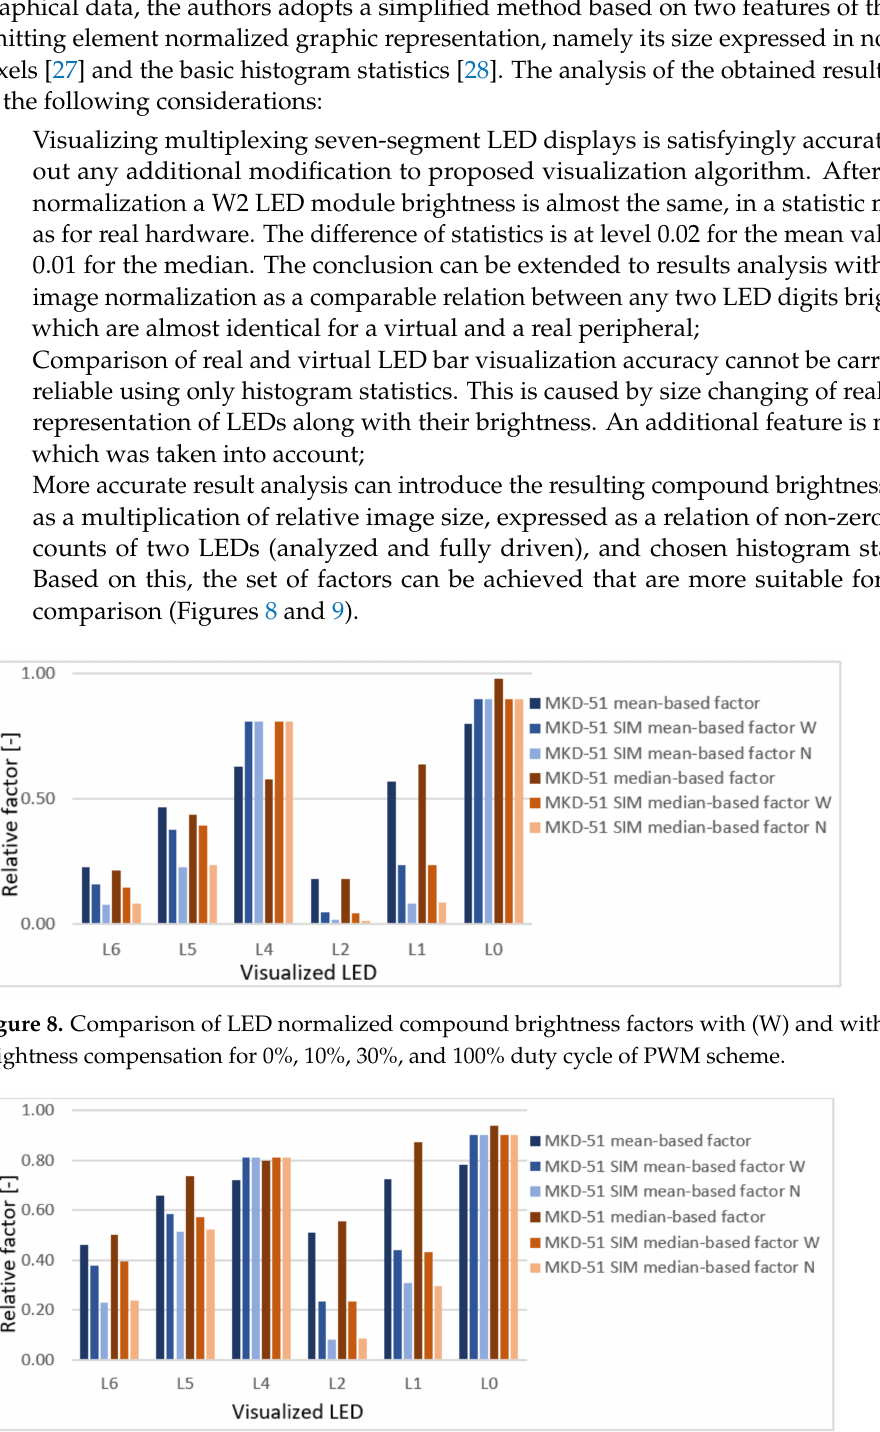
Figure 9. Comparison of LED normalized compound brightness factors with (W) and without (N) brightness compensation for 0%, 30%, 60%, and 100% duty cycle of PWM scheme for different photo exposure of the real